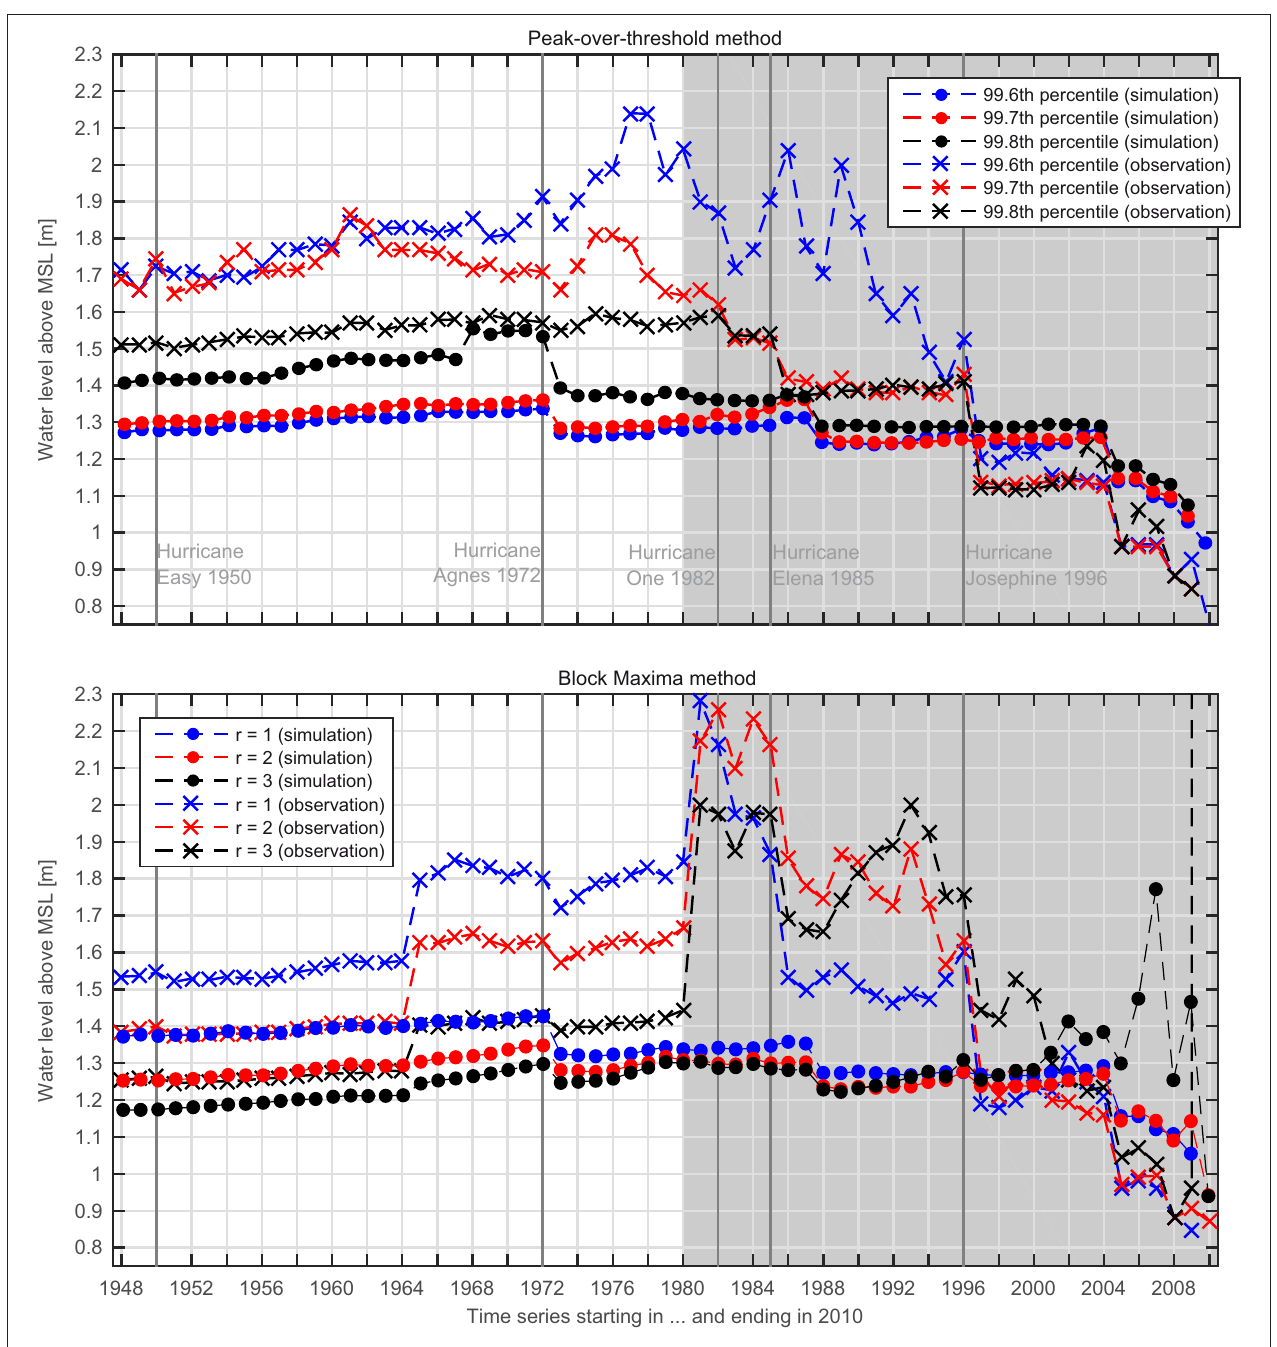
FIGURE 5 | Testing statistical approaches: 100-year return water level, estimated with different samples (colors) and with decreasing time series lengths (x-axis); the gray background denotes time series lengths which are too short for a reliable return level estimation (<30 years).